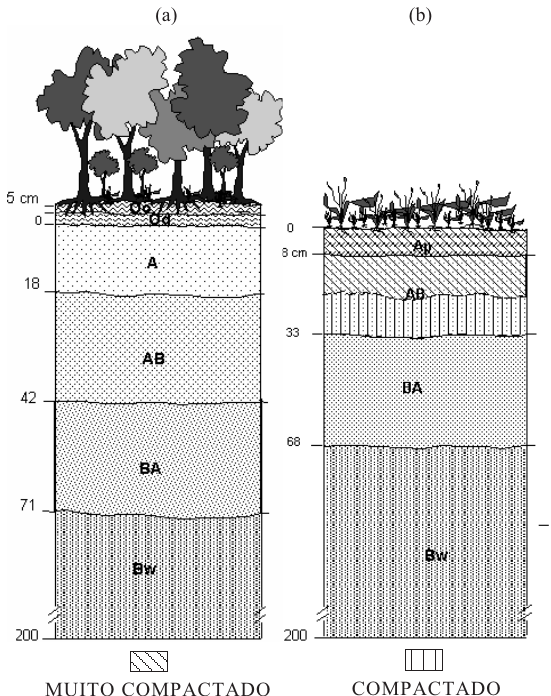
Figura 1. Ilustração esquemática da subdivisão dos horizontes dos perfis do Latossolo Vermelho sob floresta nativa (a) e forrageira